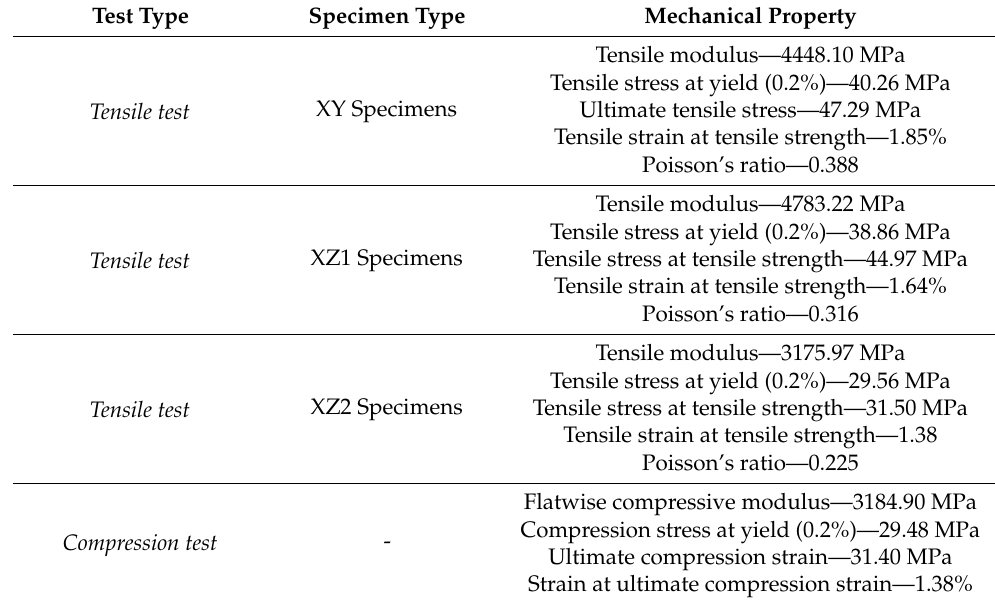
Table 10. Experimentally determined mechanical properties for the CPE CF112 Carbon